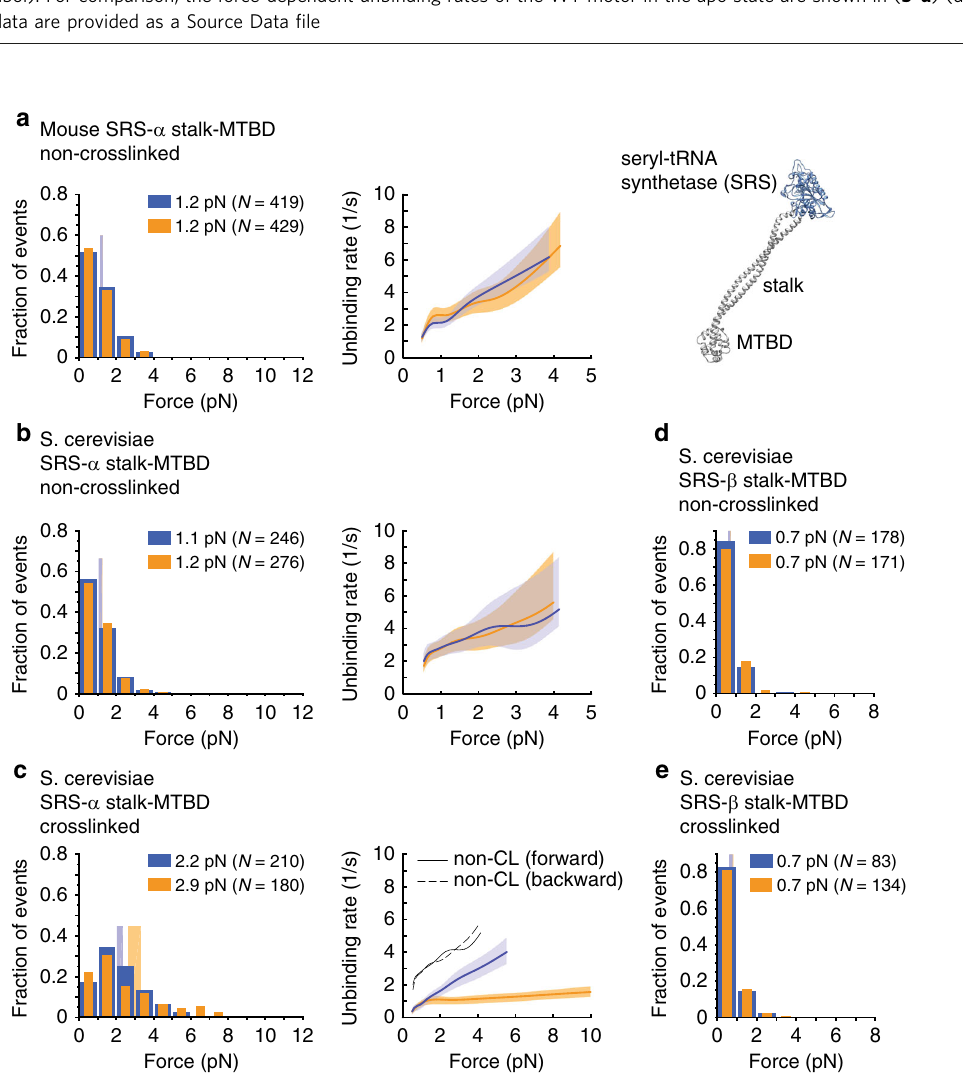
Fig. 3 Tension direction alters dynein MT-binding strength via sliding of the stalk helices. a High-af fi nity ( α ), low-af fi nity ( β ) and intermediate-af fi nity ( γ ) helix registrations of the dynein stalk generated from the morphing structure described in the Supplementary Note 1. b , top: Normalized histograms of primary forward and backward unbinding forces for the Dyn1 331kDa - α CL mutant, with mean values noted (95% CIs [2.0, 2.3] and [2.5, 3.0] pN, estimated by bootstrapping 4000 samples). b , bottom: Unbinding rate vs. force derived from the data above. The shaded areas are 95% CIs for the mean rates, estimated by bootstrapping. c As in ( b ), but for the Dyn1 331kDa - β CL mutant (95% CIs [0.6, 0.7] and [0.7, 0.8] pN). The depicted zero-load unbinding rate of 3.5 ± 0.1 s − 1 (characteristic rate ± SEM) (red circle) represents the inverse of the time constant obtained from the CDF analysis of the MT-bound lifetimes measured via TIRF microscopy (Supplementary Fig. 2c) (the 95% CIs of the measured unbinding rate (lower limit, 3.3/s; upper limit, 3.6/s) are not shown as they are shorter than the height of the symbol). d As in b , but for the Dyn1 331kDa - γ CL mutant (95% CIs [1.5, 1.7] and [1.6, 1.7] pN). e As in ( b ), but for the AAA1 E/Q Dyn1 331kDa - α CL mutant and 1 mM ATP (95% CIs [2.0, 2.3] and [2.5, 3.0] pN). f As in ( e ), but with 2 mM TCEP to cleave the disul fi de bonds of the stalk helices (95% CIs [0.6, 0.8] and [0.7, 0.8] pN). g As in ( b ) but for the AAA1 E/Q Dyn1 331kDa mutant and 1 mM ATP (95% CIs [0.7, 0.7] and [0.7, 0.7] pN). The depicted zero-load unbinding rate of 3.0 ± 0.1 s − 1 (red circle) was derived from Supplementary Fig. 2d as described for the zero-load unbinding rate in c (the 95% CIs of the measured unbinding rate (lower limit, 2.8/s; upper limit, 3.1/s) are not shown as they are shorter than the height of the symbol). For comparison, the force-dependent unbinding rates of the WT motor in the apo state are shown in ( b – d ) (dashed and solid black lines). Source data are provided as a Source Data fi le